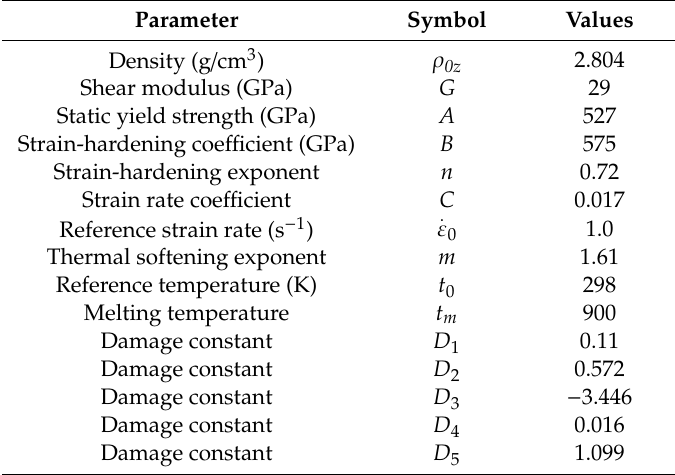
Figure 4. A diagrammatic sketch of the experimental apparatus.